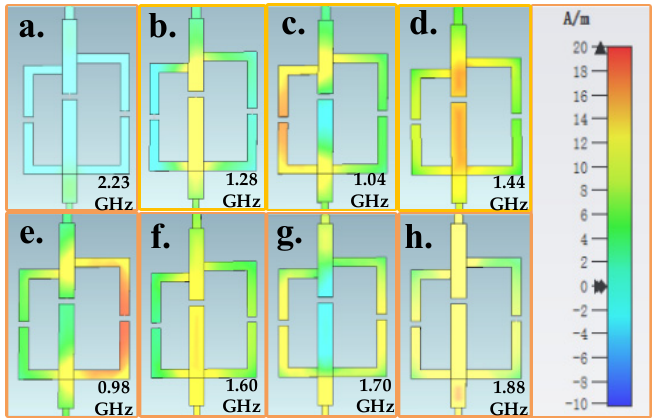
Figure 7. Simulated surface current distribution of the STLS at different states. Panels ( a – h ) corre- spond to states 000–111.